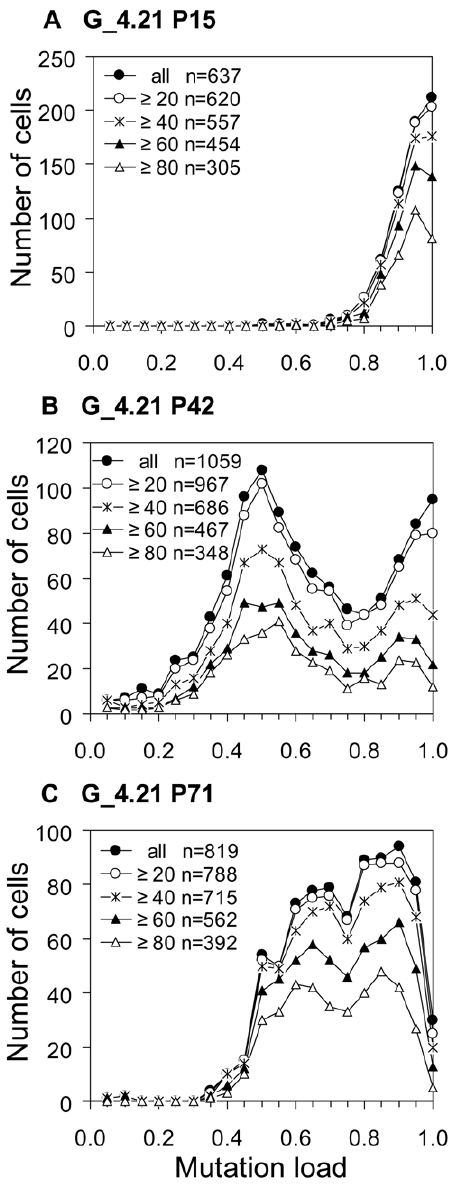
Figure 4. Cellular heteroplasmy evolution of clone G_4.21 by Padlock/RCA analysis. The m.3243A . G mutation load of single cells was determined by Padlock/RCA in passages 15 (A), 42 (B) and 71 (C). Dots/cell number may reflect detection efficiency, but also the actual segregation unit number. Since detection efficiency is arguable low (Supplemental Figure S2), in the order , 5%, cells with a wide range of dots/cell number will be observed, independent of true variations in segregation unit number. The frequency histograms of the three passages are shown separately at increasing stringency of the dots/cell criterion ( . 0 (all) up to $ 80 dots/cell) to emphasize that the peaks and shoulders are genuine. Thus, the outcome of the experiment does not change substantially with the smaller amount of cells with larger dots/ cell ( $ 60 or $ 80), which makes calculation of mutation load more solid (See also Figure S1 for choice of stringency and bin size). Due to the choice for a 5% bin, it is not apparent that the cells in the 95–100% bin of P15 are for the very great majority heteroplasmic: in that bin, 94% of the cells with $ 40 dots/cell and 92% of the cells $ 80 dots/cell bin had in fact one or more green (wild type mtDNA)